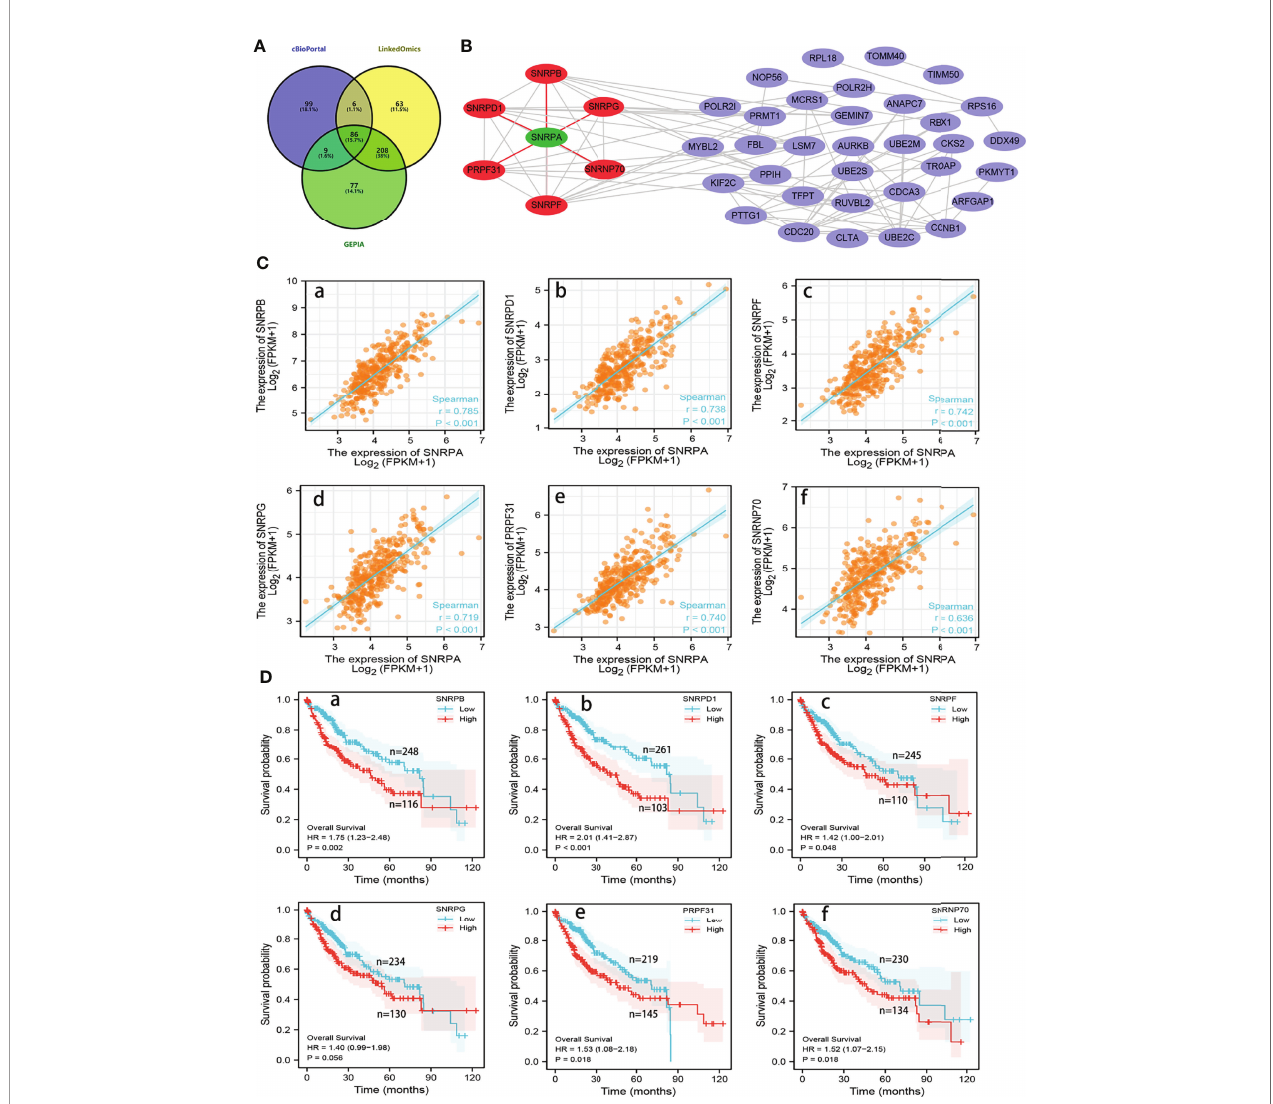
FIGURE 6 | Analysis of co-expressed genes with SNRPA in HCC. (A) 86 overlapping co-expressed genes with SNRPA were identi fi ed from the three databases. (B) The PPI network showed that the SNRPD1, SNRPB, SNRPG, SNRPF, PRPF31, and SNRNP70 protein directly interact with SNRPA. (C) Correlation of SNRPA mRNA levels with SNRPB (a), SNRPD1 (b), SNRPF (c), SNRPG (d), PRPF31 (e), and SNRNP70 (f) mRNA levels. (D) Associations between SNRPB (a), SNRPD1 (b), SNRPF (c), SNRPG (d), PRPF31 (e), and SNRNP70 (f) mRNA levels and the OS of HCC